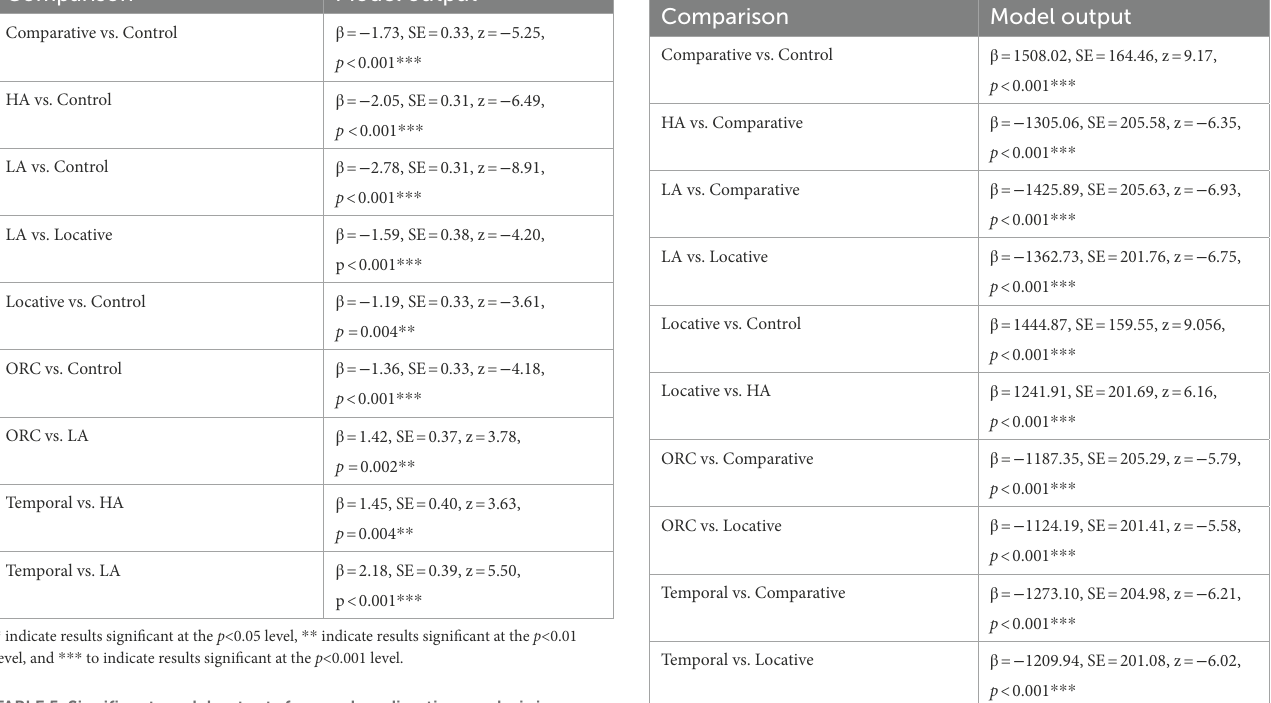
TABLE 5 Significant model outputs for word reading time analysis in Experiment 1.